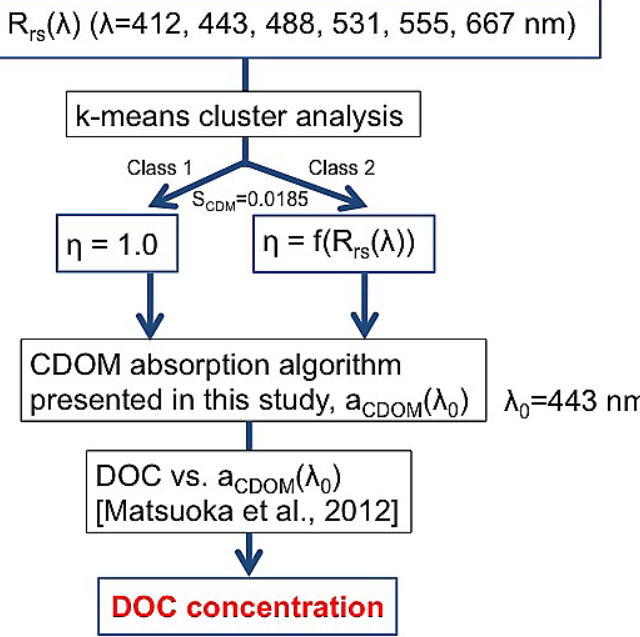
Fig. 6. A flow chart for deriving DOC concentrations for Arctic waters using satellite ocean color